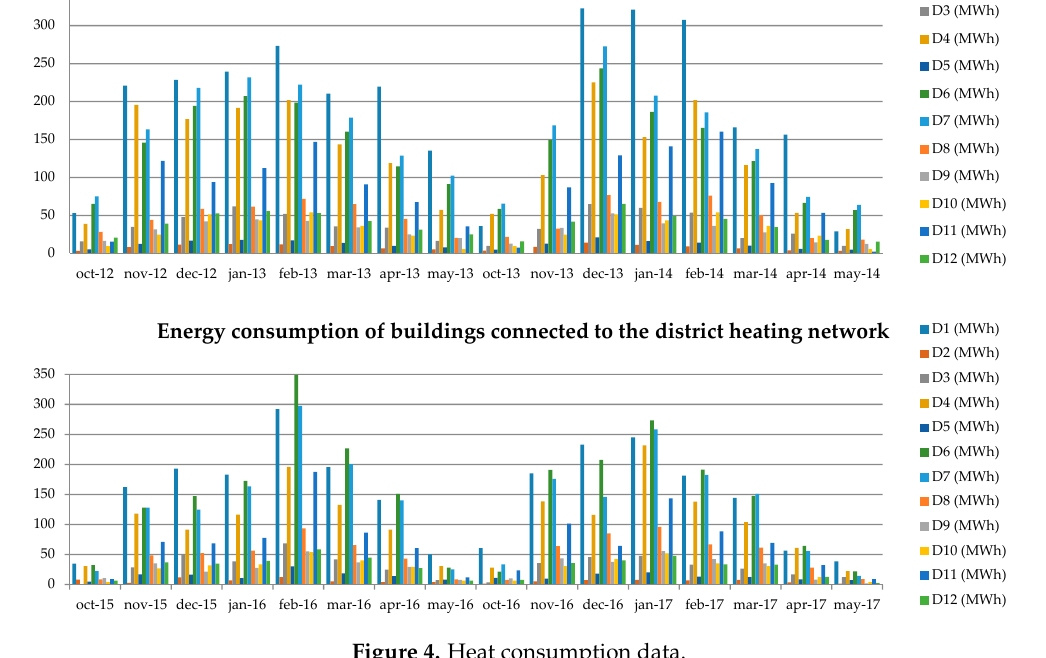
Figure 4. Heat consumption data.